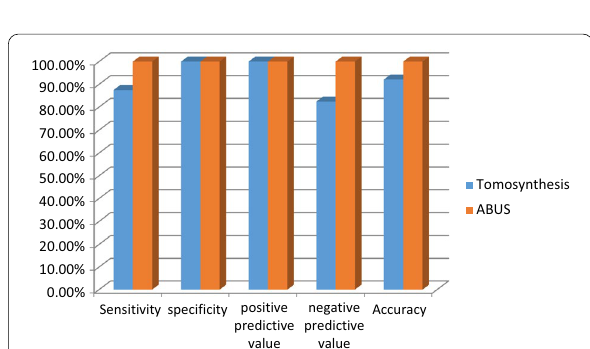
Fig. 3 Comparison between accuracy measures of tomosynthesis and